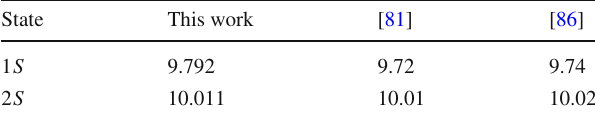
Table 5 Comparison of ground and first radially excited states for bb diquark. All results are in GeV